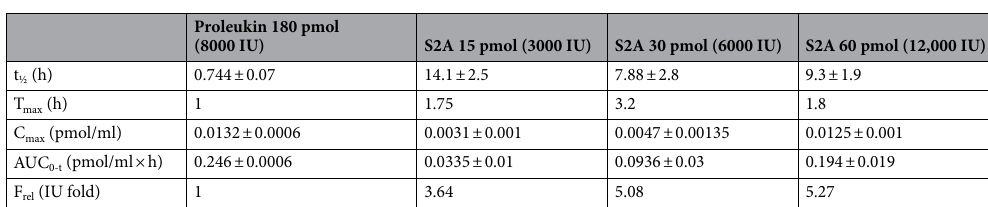
Table 3. The results of non-compartmental pharmacokinetic analysis of the Proleukin and S2A concentration versus time data. Average ± SD, n = 5. Analysis performed in PKsolver add-in to Microsoft